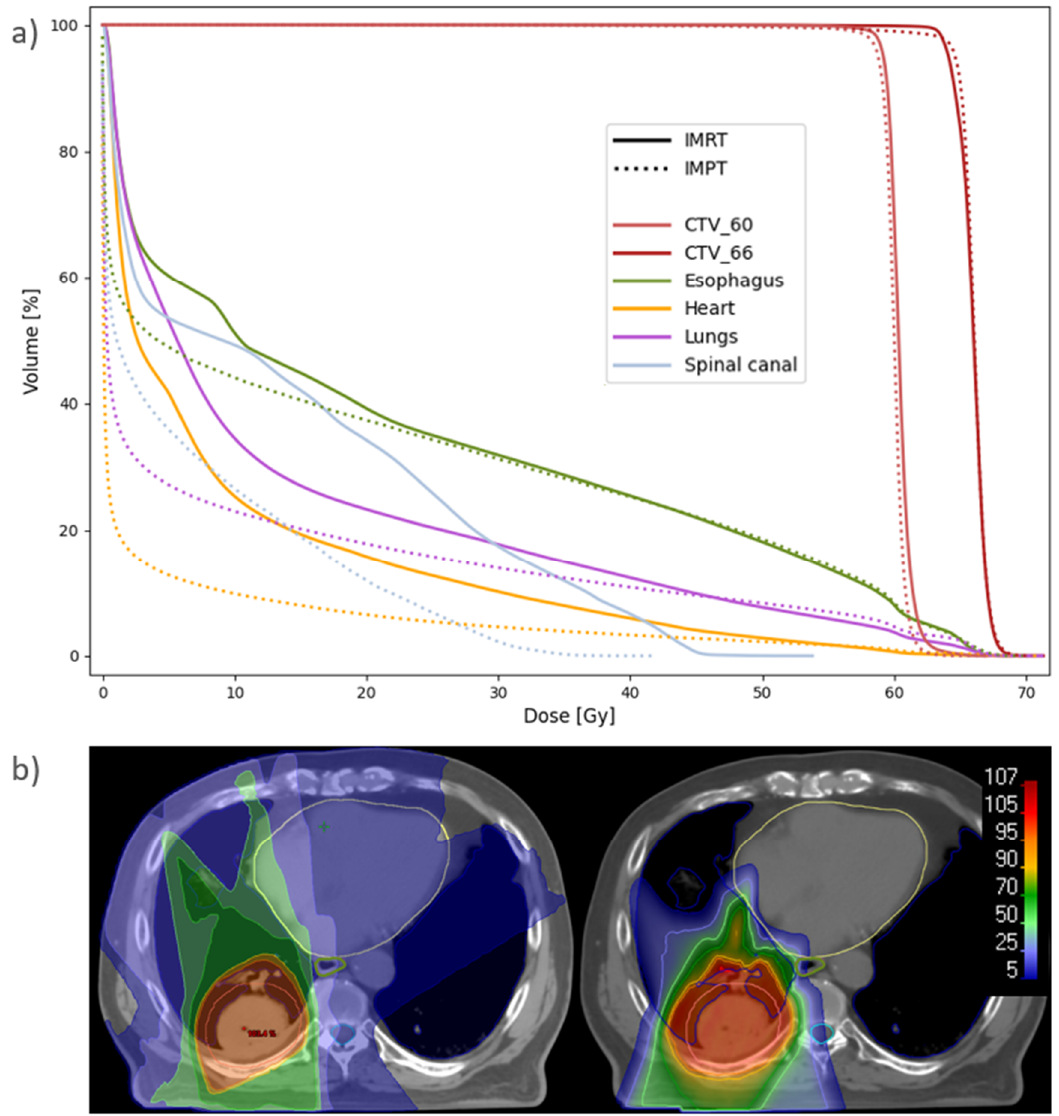
Figure 5. ( a ) Population average DVH for IMRT and IMPT plans recalculated at Start. Six patients had CTV_60 and nine had CTV_66. ( b ) Dose distribution for patient 7 with IMRT ( left ) and IMPT ( right ), recalculated at Start. The spread of the low and medium doses results in higher mean doses to the lungs (blue), esophagus (green) and heart (yellow) with IMRT. The CTV is delineated in pink, and the spinal canal in cyan.